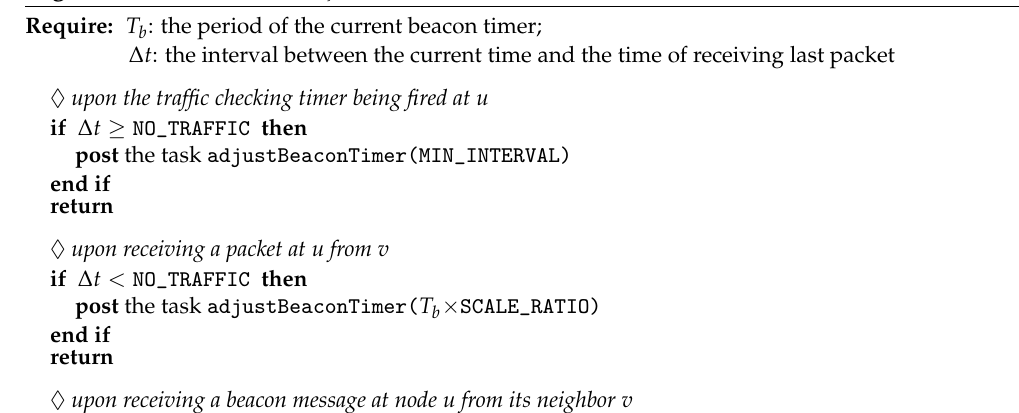
Algorithm 2 Beacon timer adjustment of